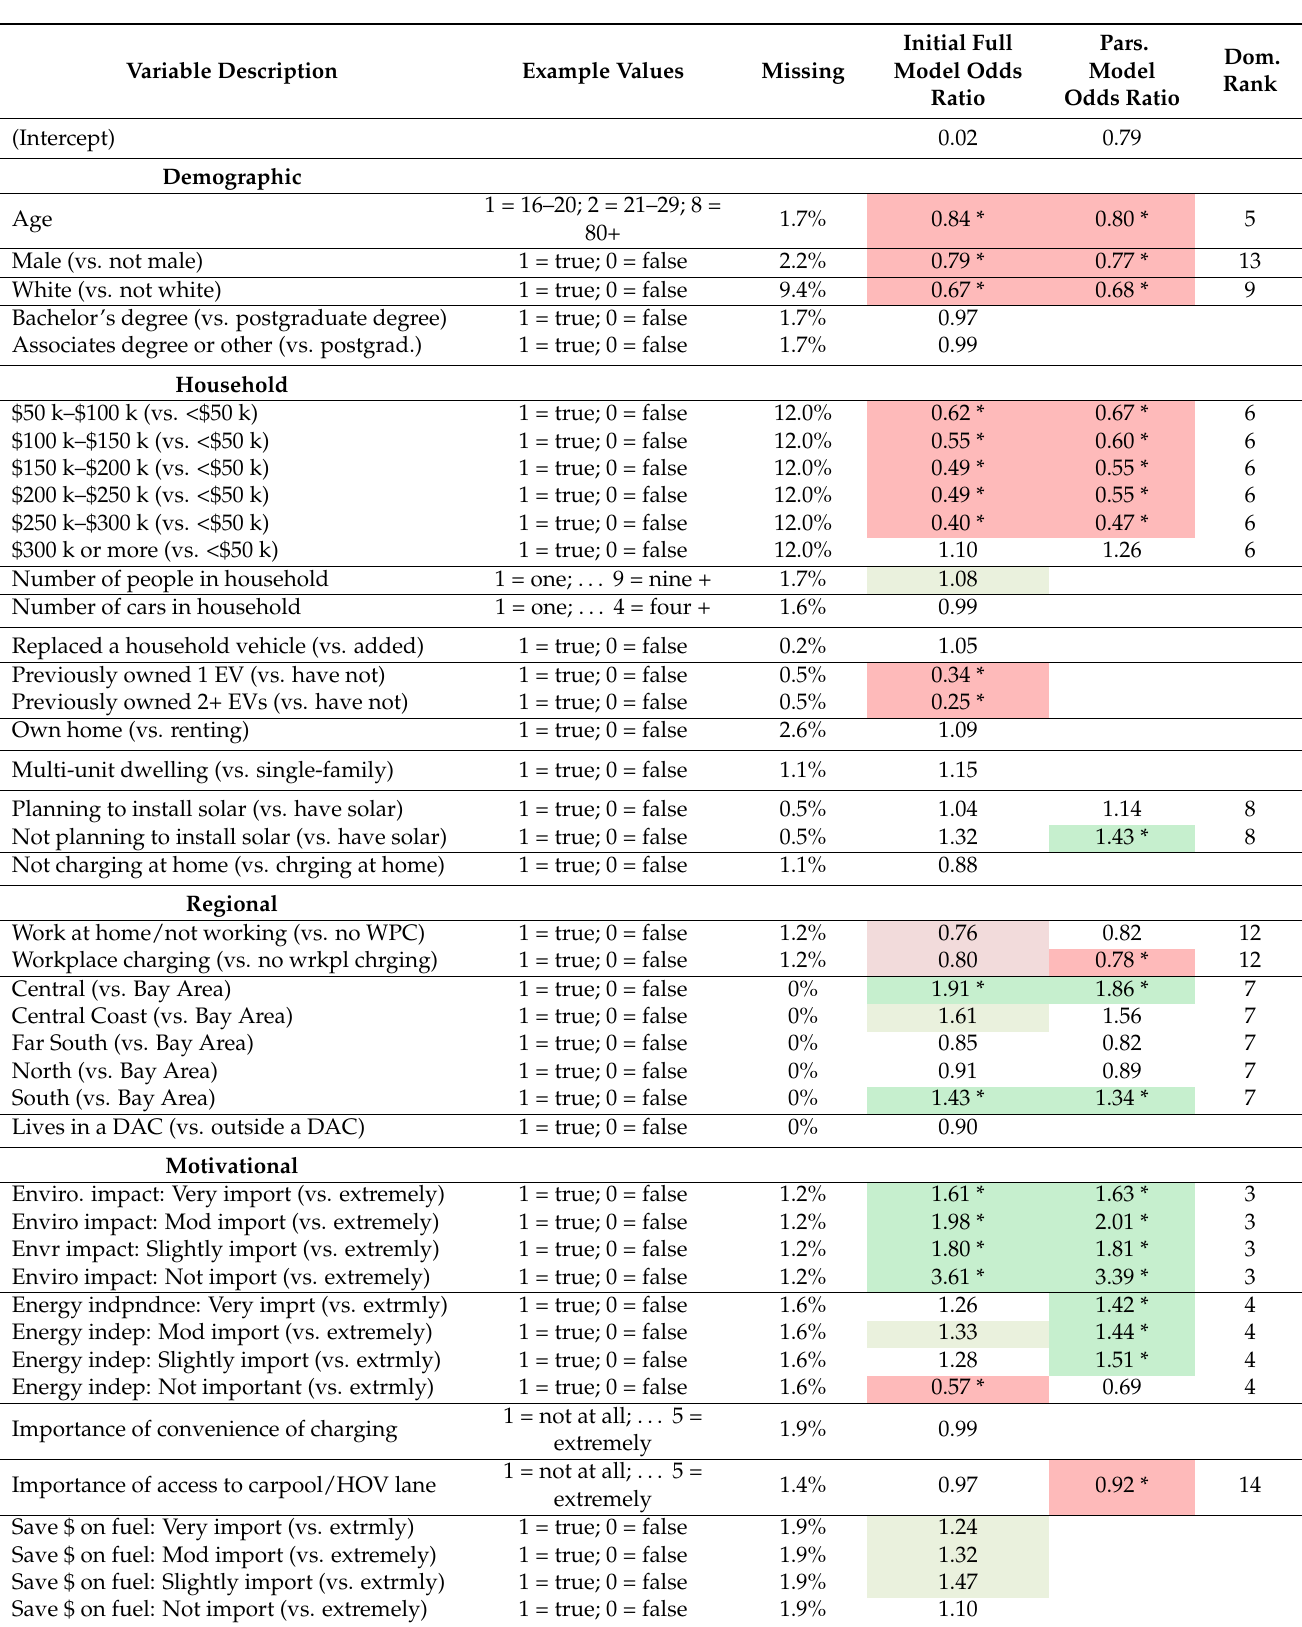
Table 6. BEV Variables and Model